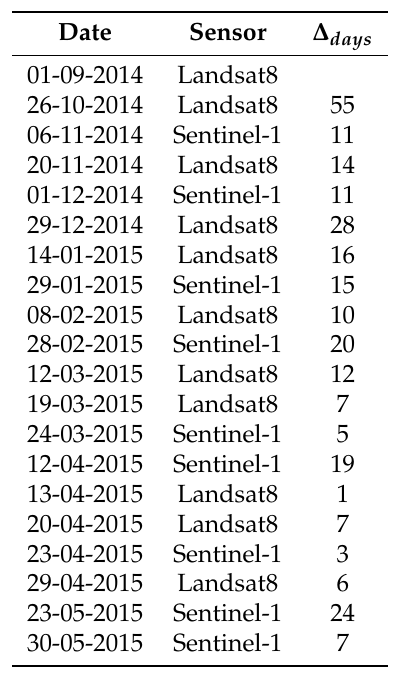
Table 4. Acquisition dates and sensor type for the data used in this